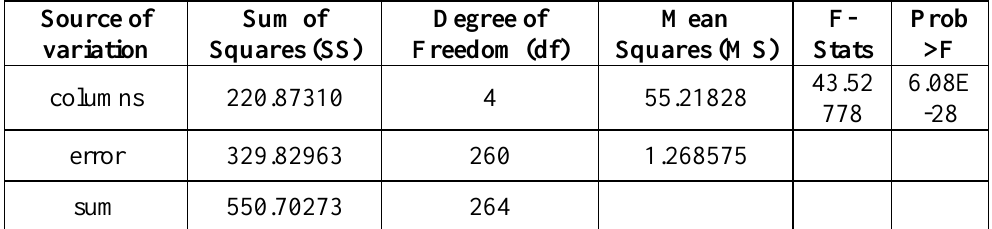
Table 10. One-Way Analysis of Variance of Value at Risk